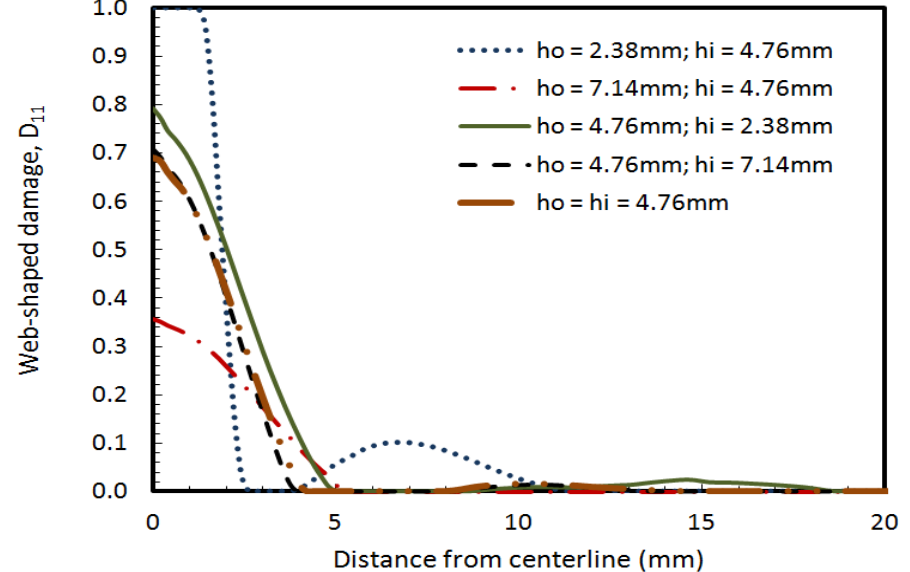
Figure 10. Effect of inner and outer plies thickness on Damage variable D at surface S2 for small missile impact.